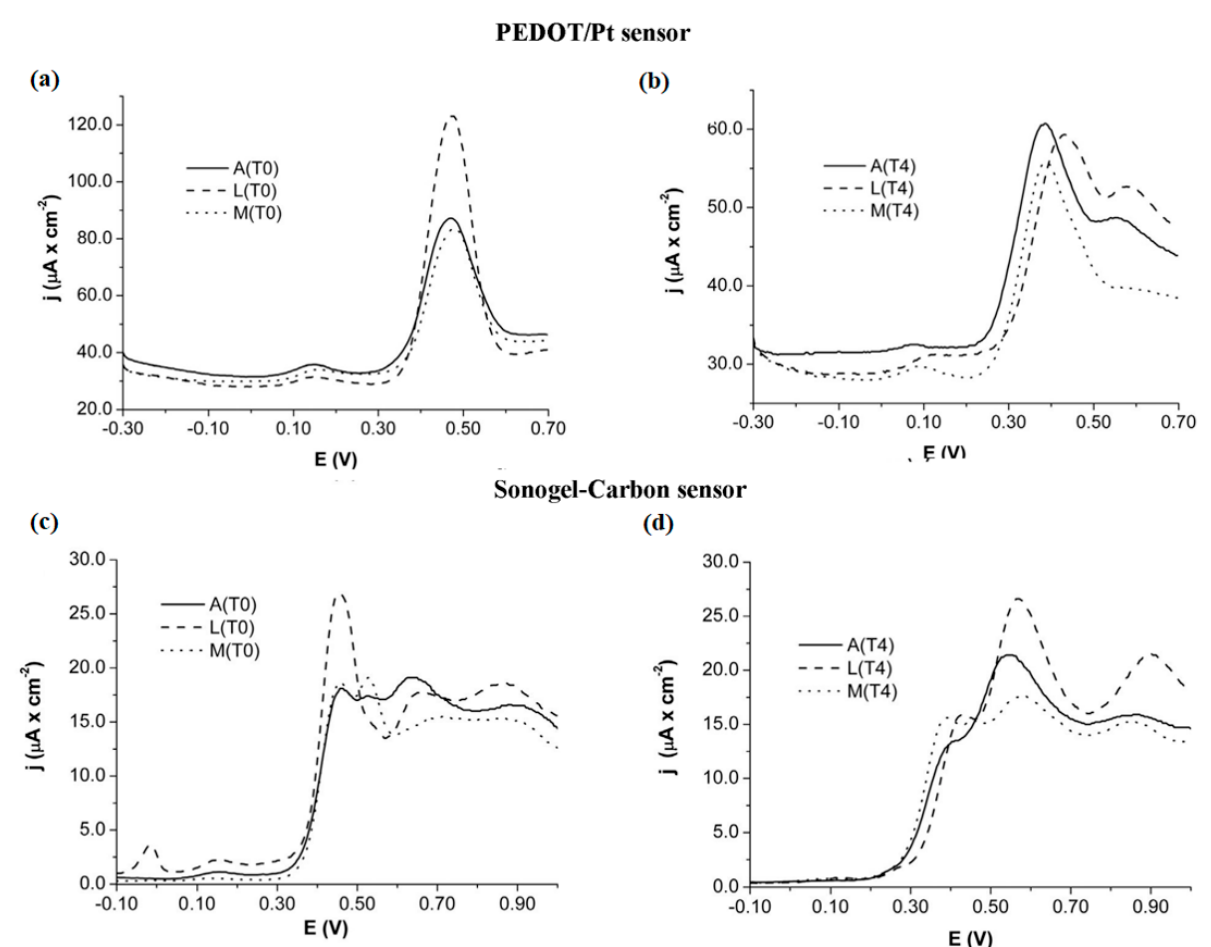
Figure 5. Voltammetric responses obtained with PEDOT/Pt ( a , b ) and sonogel-carbon sensors ( c , d ) for three types of Italian grape varieties, Ancellota (A), Lambrusco Marani (L) and Malbo Gentile (M), collected at 10 days (T0) and 50 days (T4). Reprinted with permission from ref. [114]. Copyright 2018, Elsevier.